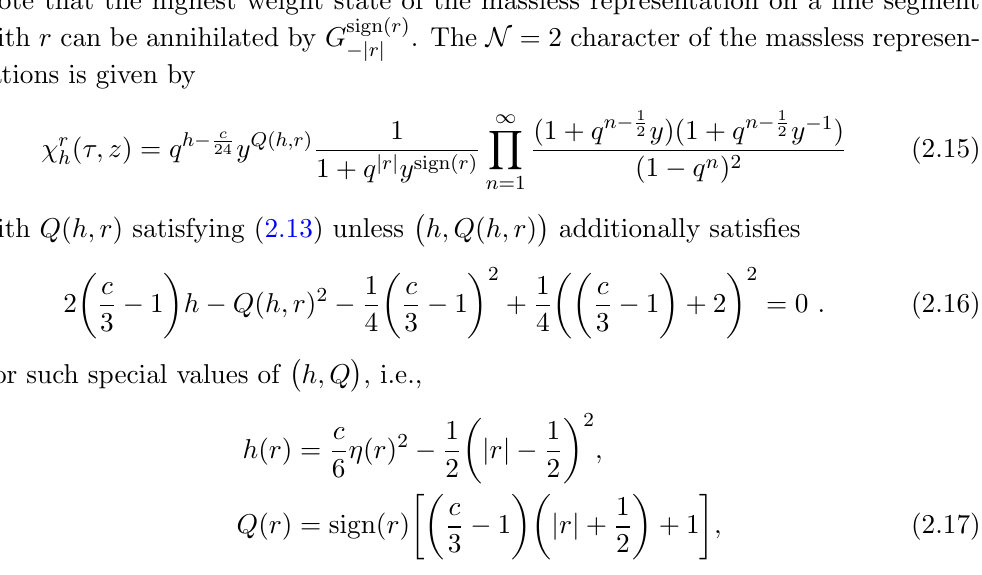
Figure 3 . Domain of the unitary irreducible representation of c = 6, N = 2 super-Virasoro algebra. The orange curve passes through the points that satisfy a relation 2 h (cid:0) Q 2 + 2 = 0. Note that the highest weight state of the massless representation on a line